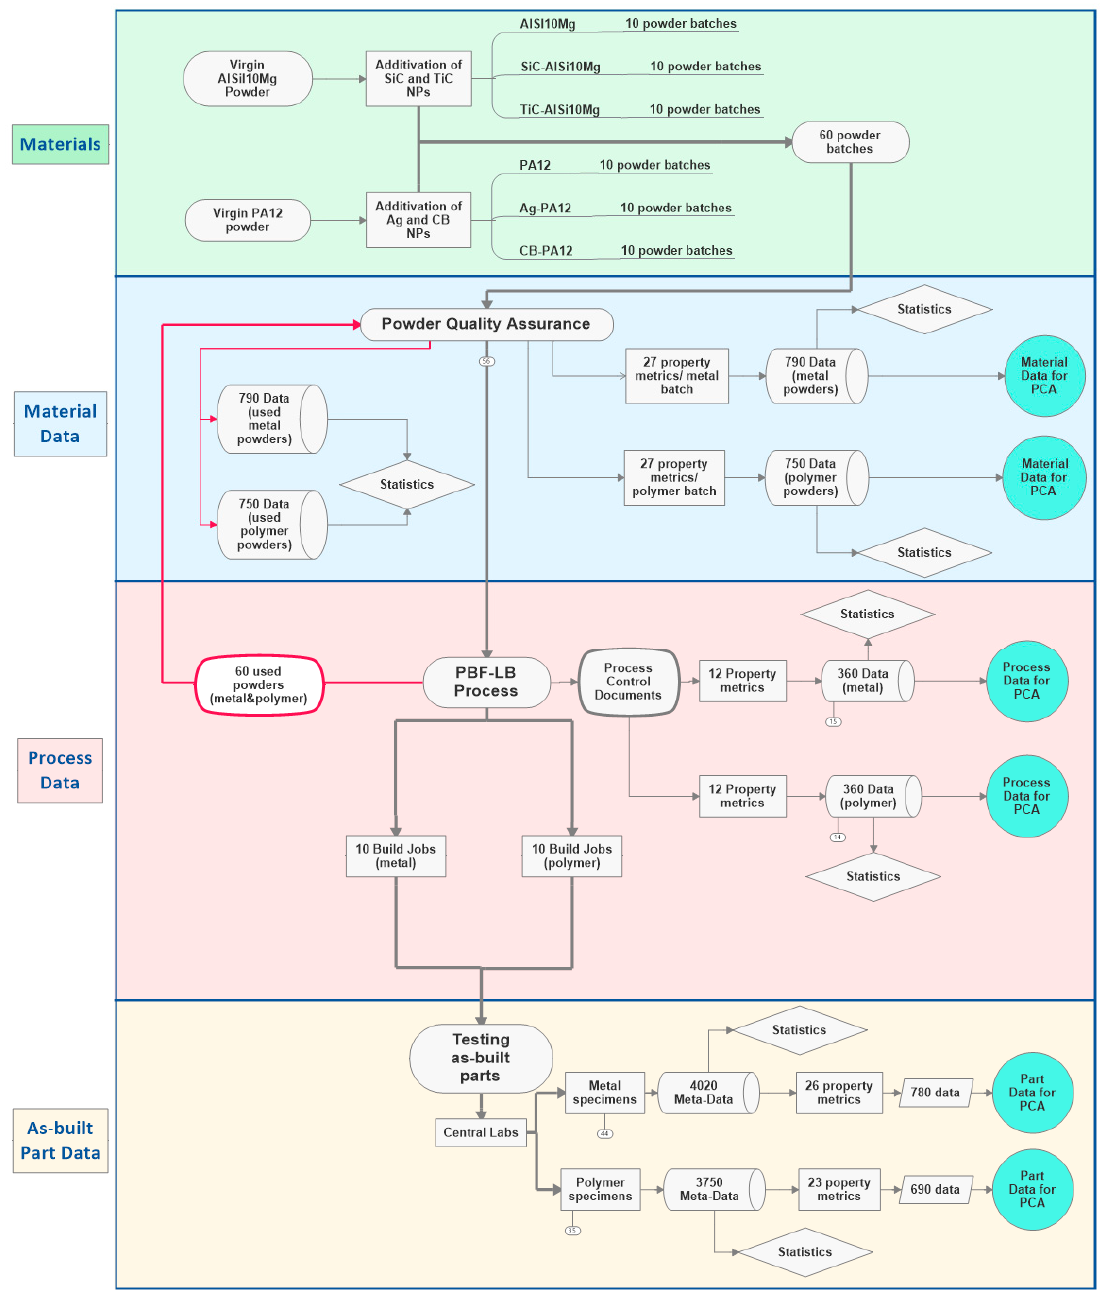
Figure 8. Material, process, part data flow chart of inter-laboratory study, and the entire process chain. Numbers are based on testing 1 unmodified and 2 nanoparticle-additivated powders, each for metal and polymer powder with 10 processing participants (each for polymer and metal) plus central lab participants.